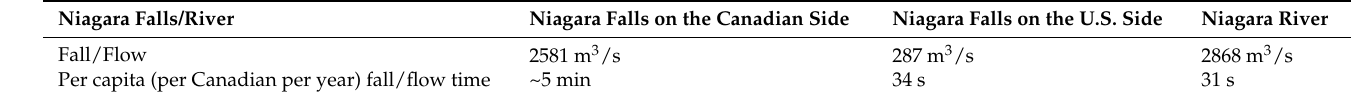
Table 1. Water availability for Canadians from the Niagara River flow only